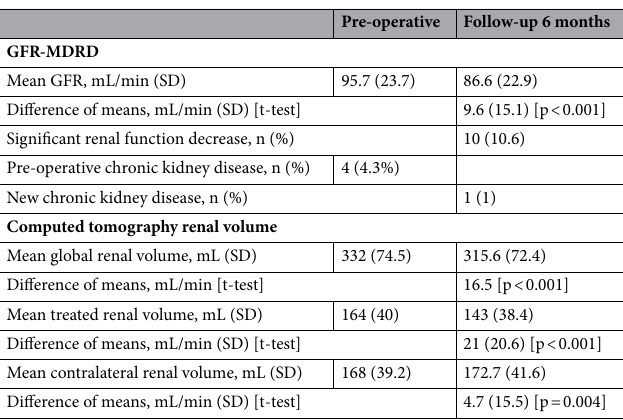
Table 2. Renal function and volume